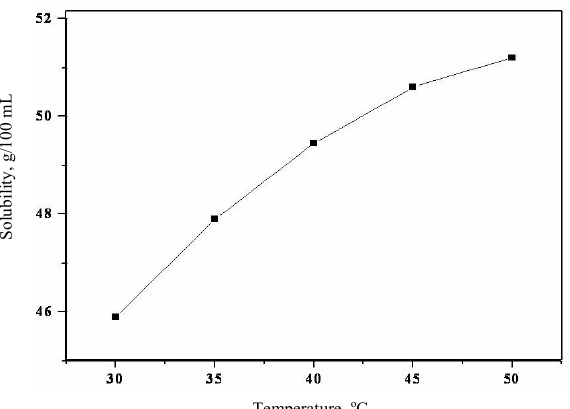
Figure 2. The solubility curve of CLMHCl single